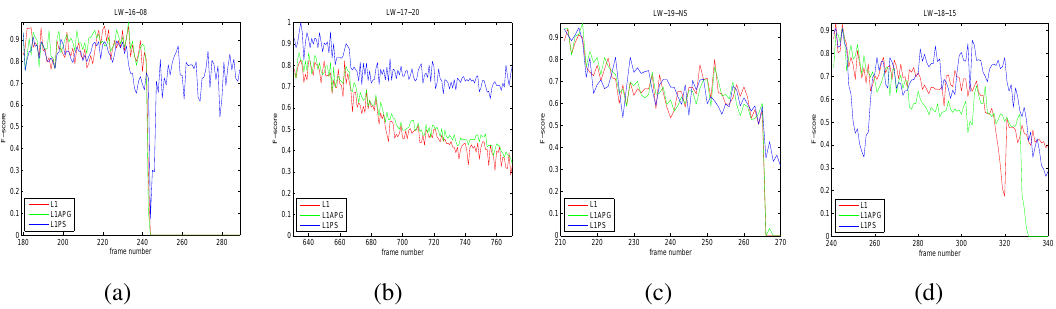
Figure 6. Quantitative comparison of three trackers in terms of F-score. ( a ) LW-16-08;